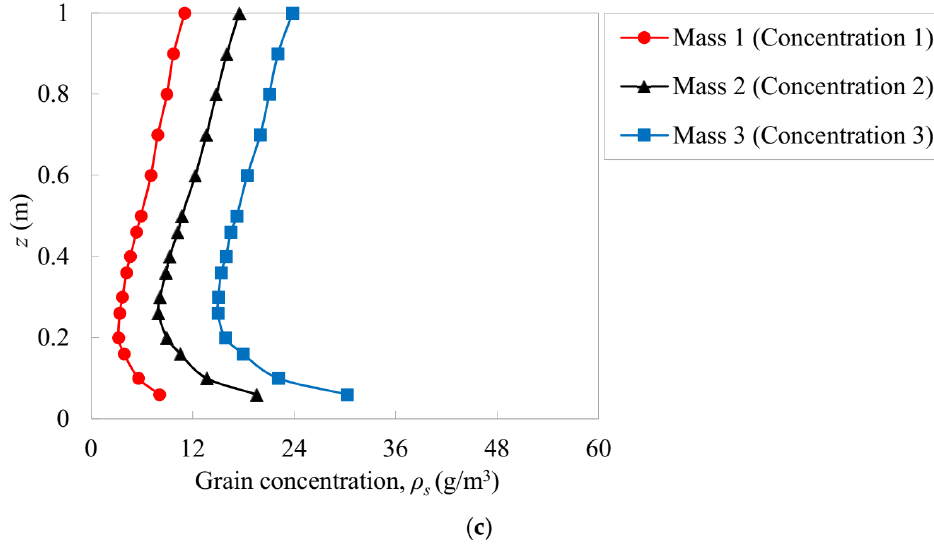
Figure 5. Grain concentration profiles: ( a ) At the test wind speed of 10 m/s; ( b ) At the test wind speed of 13 m/s; ( c ) At the test wind speed of 16